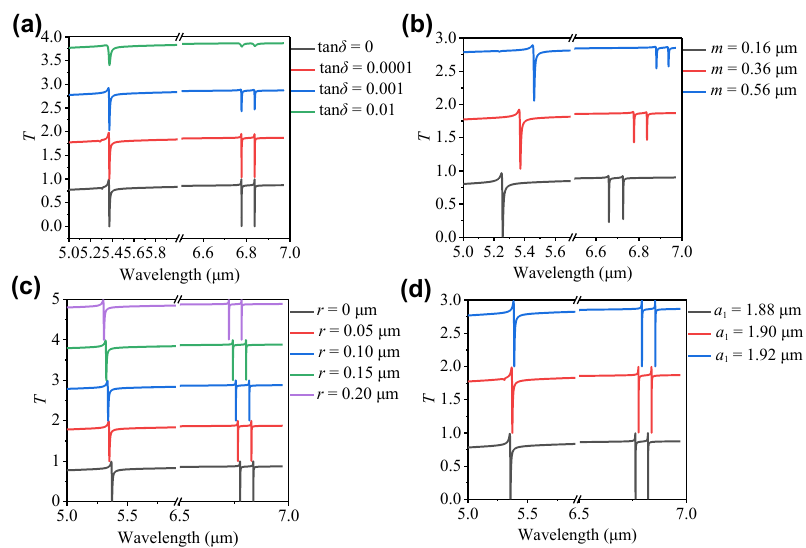
substrate. 2 2 1